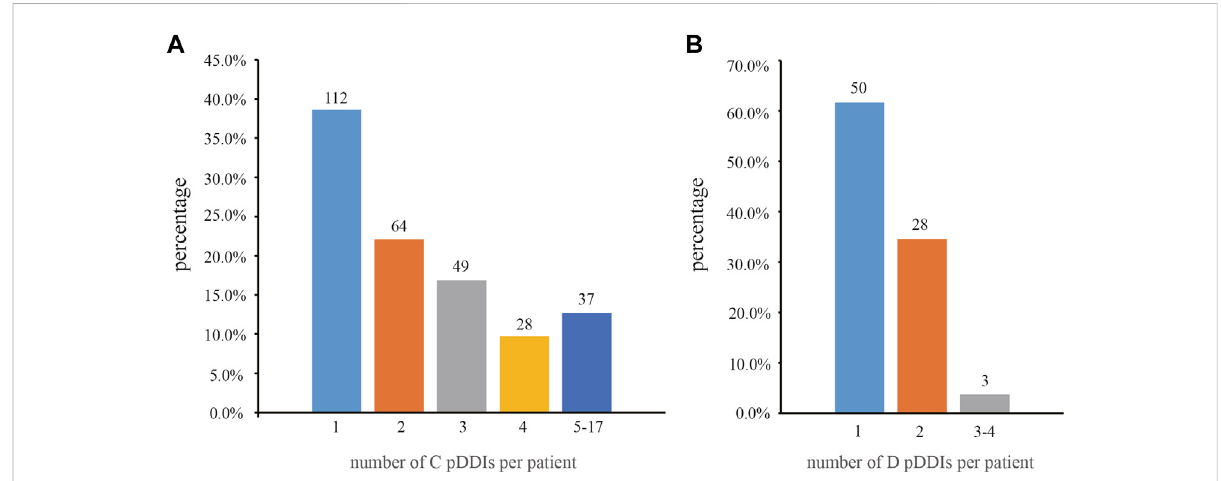
FIGURE 1 Frequency and percentage of pDDIs per patient based on risk category. (A) category C ( n = 290); and (B) category D ( n = 81). Percentage was calculated out of number of patients with C or D pDDIs. pDDIs, potential drug-drug interactions.